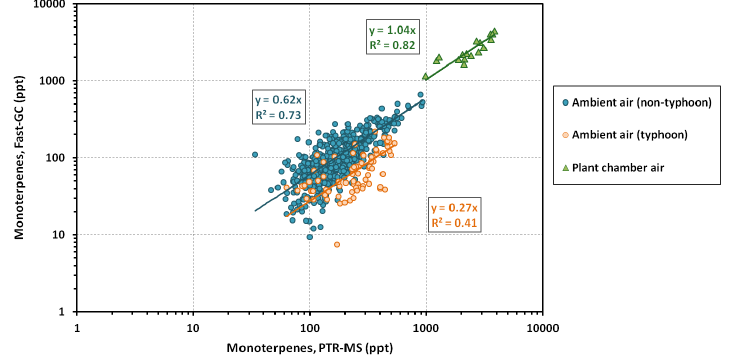
Fig. 7. Correlation plots of Fast-GC vs. PTR-MS derived total monoterpene mixing ratios, based on simultaneous measurements during ambient air observations (see Sect. 3.2.2) and plant chamber measurements (see Sect. 3.1). In each case, PTR-MS values are averaged over the relevant Fast-GC sampling